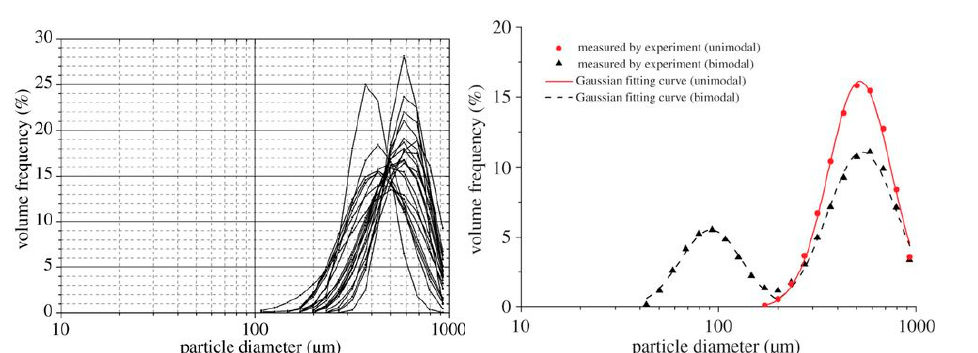
Figure 1. Unimodal sneeze droplet diameter distribution from [11]: experimental data collected (left panel); Gaussian fitting curve (right panel). Table 1. Sneeze, breathing, and site condition parameters.